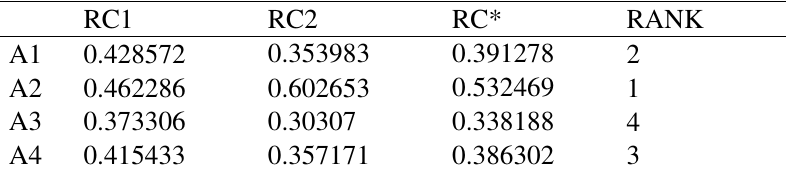
Table 12 The final ranking of